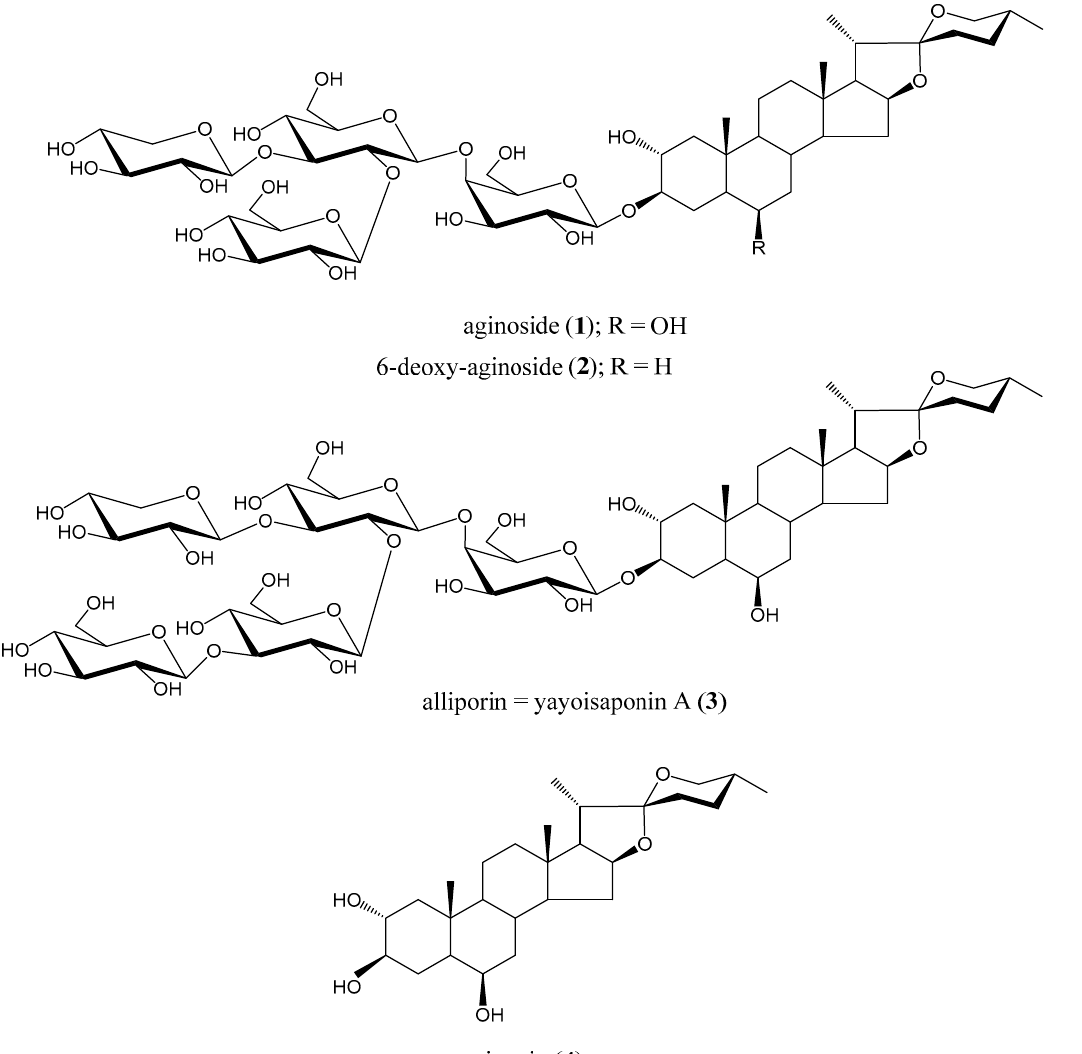
Figure 1 . Structures of Compounds 1 – 4 isolated from Allium porrum